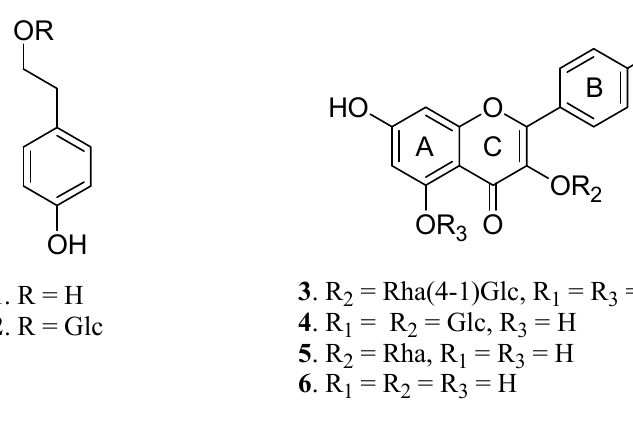
Figure 1. Chemical structures of compounds 1 – 8 isolated from